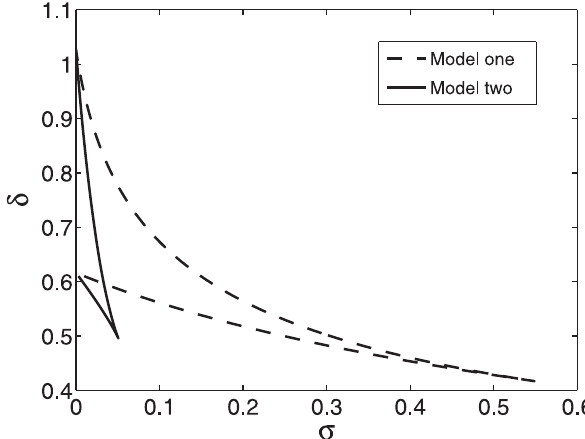
Figure 4. Bifurcation diagrams of the two models with s and d as control parameters. The regions enclosed by dashed and solid lines are the bistable regions of the two models. Other parameter values are l ~ 0 : 5 , c ~ 0 : 2 , a ~ 2 , m ~ 0 : 5 , b ~ 0 : 5 , and r ~ 40 .